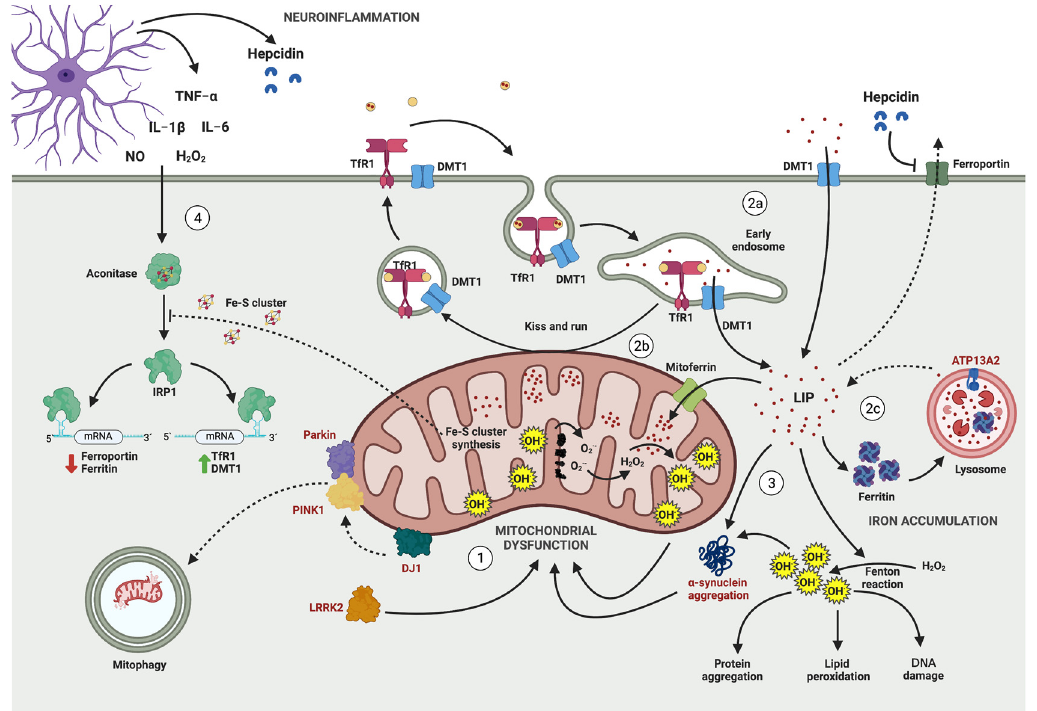
Figure 1. Interplay between neuroinflammation, mitochondrial dysfunction, iron accumulation, and α -synuclein aggregation in PD. Mitochondrial dysfunction takes place downstream of PD- associated genes mutations (encoded proteins in red), which induce mitochondrial ROS (mtROS) generation and oxidative damage ( 1 ). Mitochondrial dysfunction impairs Fe-S cluster synthesis prompting iron accumulation through IRE/IRP dysregulation. Iron uptake is mediated by TfR1 and DMT1, which are increased in PD, while ferroportin, which mediates iron export, is decreased, causing iron accumulation and an increased iron labile pool ( 2a ). Iron is transported to mitochondria by mitoferrin or by an endocytic mechanism named “kiss and run”. Iron inside of mitochondria is used for Fe-S cluster synthesis. However, mitochondrial iron accumulation catalyzes the Fenton reaction, triggering mtROS production ( 2b ). Iron excess is stored in ferritin, which is released by lysosome- mediated ferritin degradation, which is also altered in PD (2c). Cytoplasmic iron accumulation trig- gers hydroxyl radical production, which promotes lipid peroxidation and DNA damage and α - synuclein aggregation, which further enhances mitochondrial dysfunction ( 3 ). Neuroinflammation also alters iron homeostasis ( 4 ). Pro-inflammatory cytokines, NO and H 2 O 2 increases DMT1 and TfR1 protein expression and decreases ferroportin and ferritin levels through IRP1-dependent and independent mechanisms.